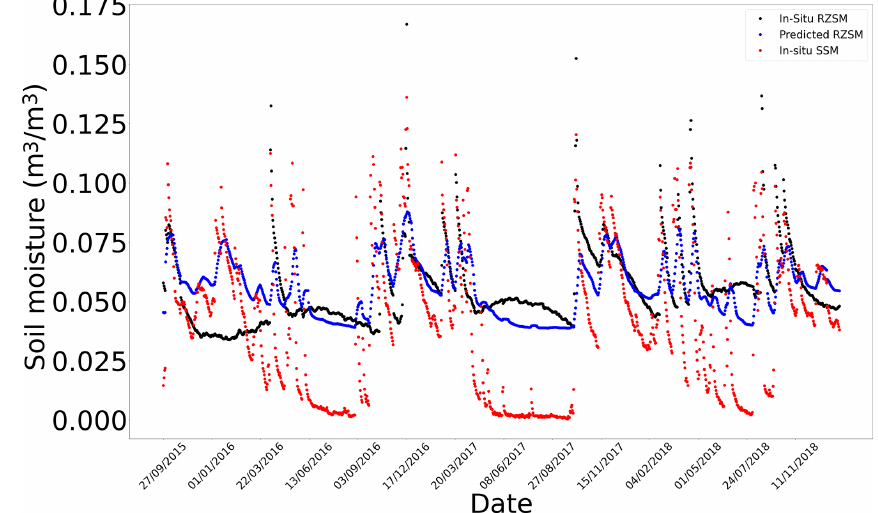
Figure G5. In situ SSM, in situ RZSM, and predicted RZSM series at station Bouhajla_164 (Tunisia) with model ANN_SSM.